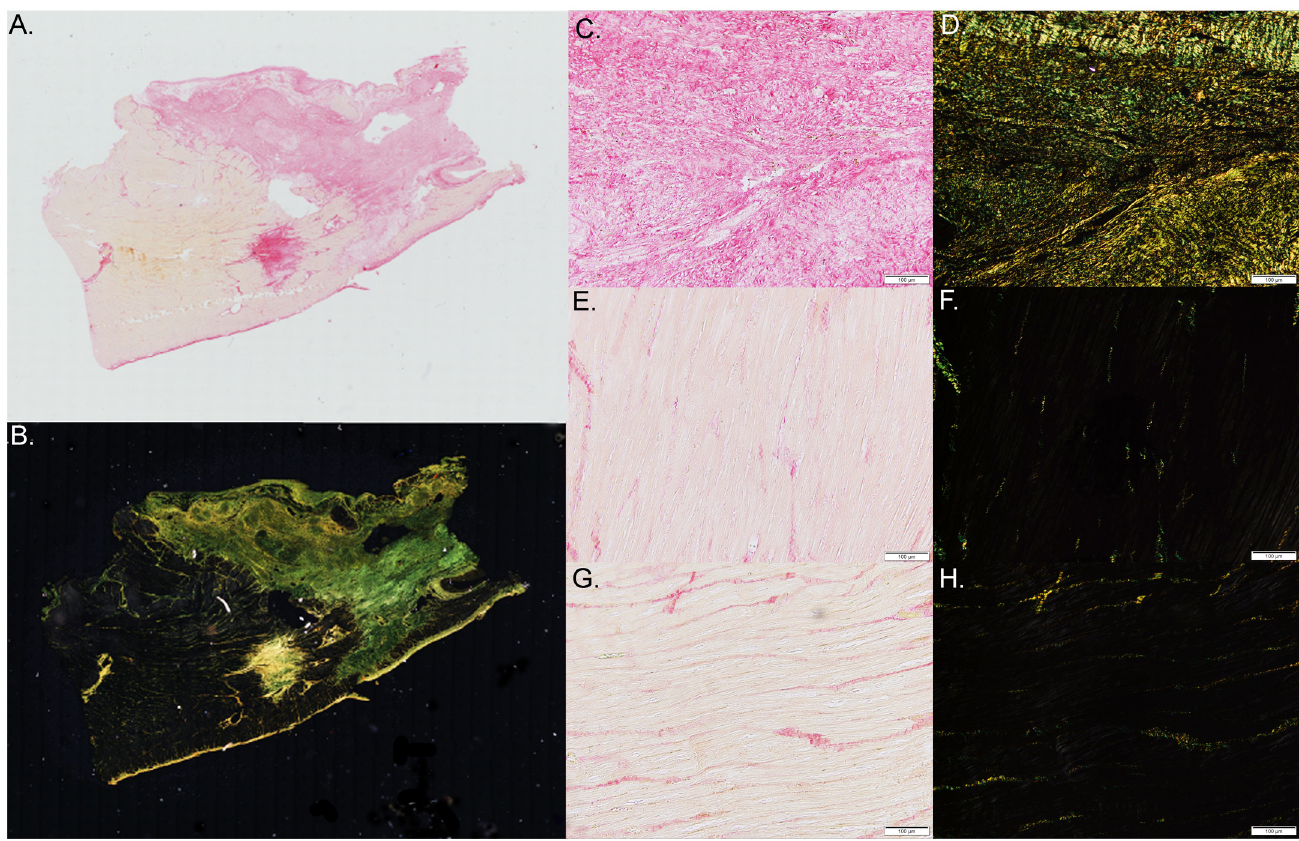
Fig 6. Fibrosis. Representative picture of a picrosirius red stained borderzone slide (A. bright field, B. polarized light) and a higher magnification of a picrosirius red stained slides isolated from the infarct area (C,D), borderzone (E,F) and remote area (G,H) of the left ventricle (bright field C,E,G, polarized light